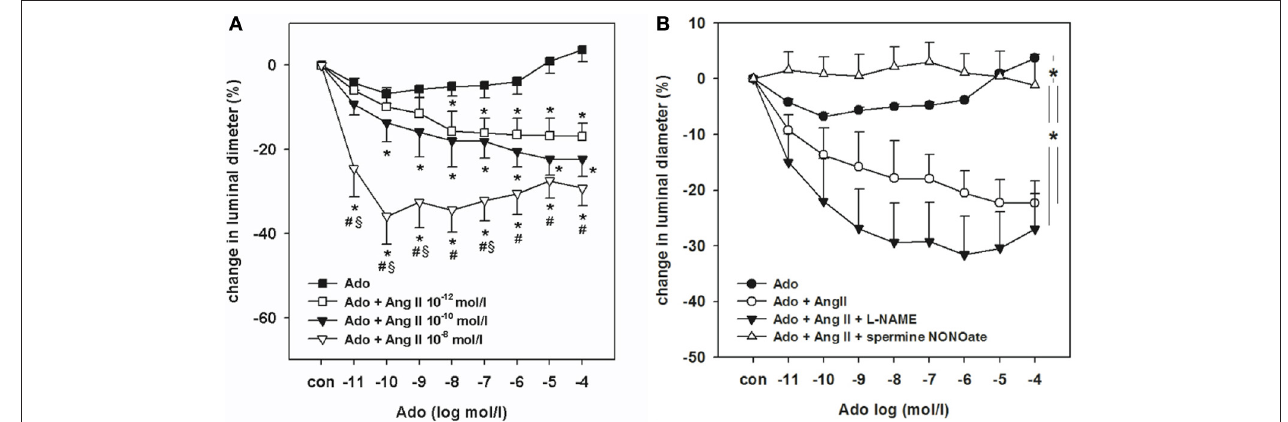
FIGURE 2 | (A) Dose response curve for adenosine on afferent arteriolar contraction in increasing concentration from 10 − 12 to 10 − 4 mol/lwith and without the presence of angiotensin II in three different doses [10 − 12 , 10 − 10 , 10 − 8 mol/l, from Lai et al. (2009)] (B) Dose response curve for adenosine in increasing